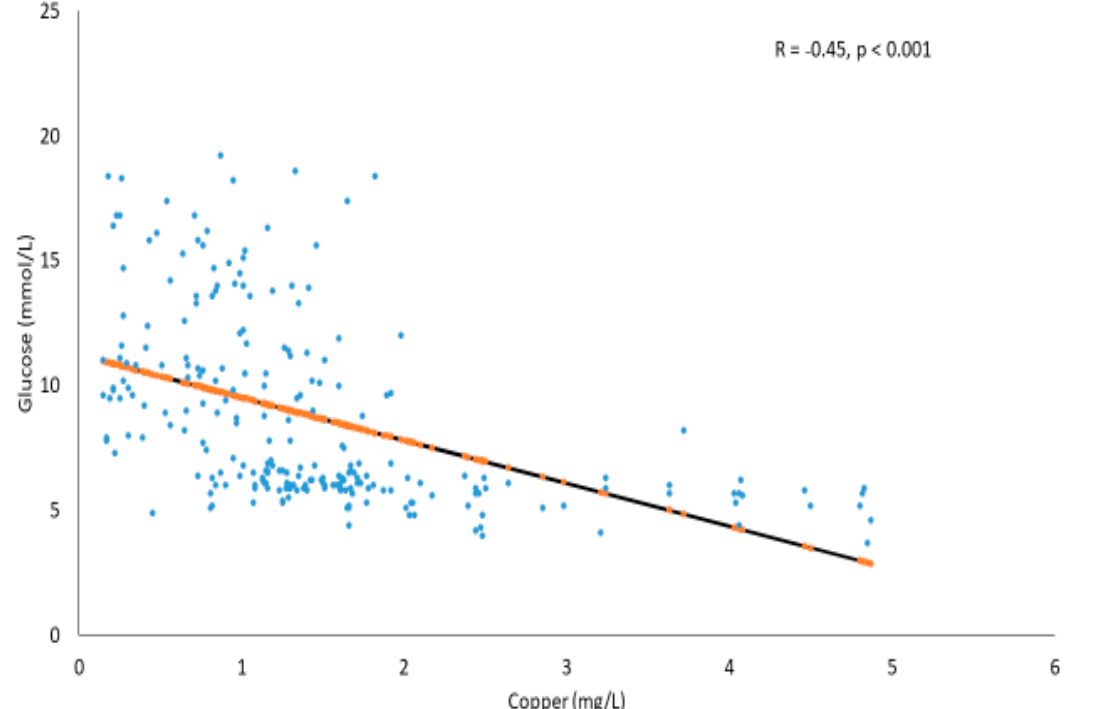
Figure 1. Correlation between glucose (mmol/L) and Cu (mg/L) in T2DM and prediabetes subjects.